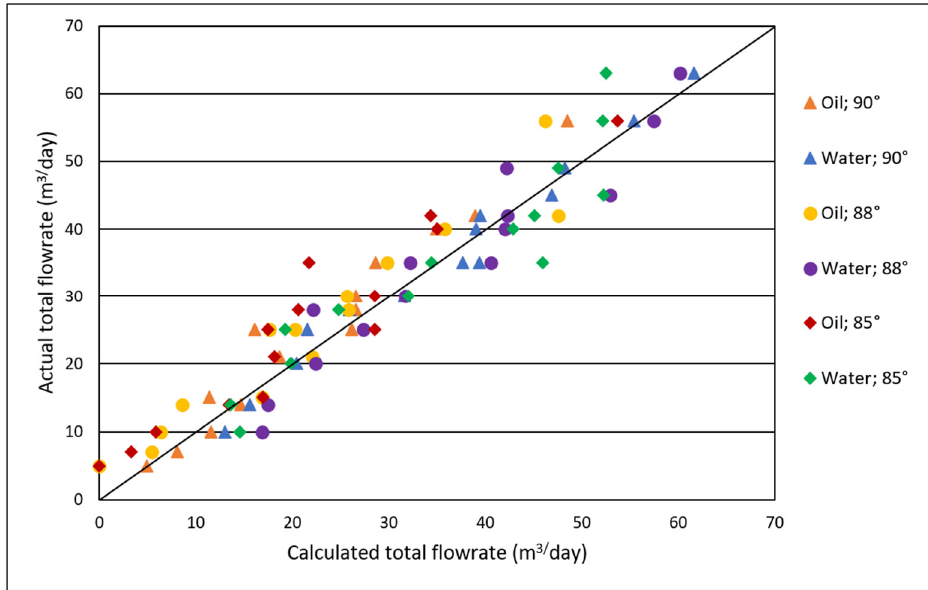
Figure 14. Calculated oil and water flowrate consistency analysis diagram.